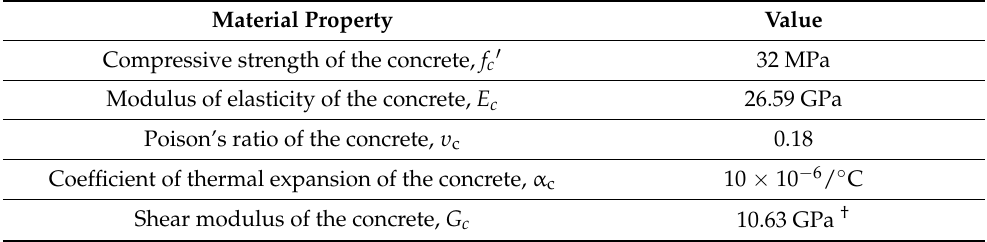
Table 2. Properties of concrete [4].